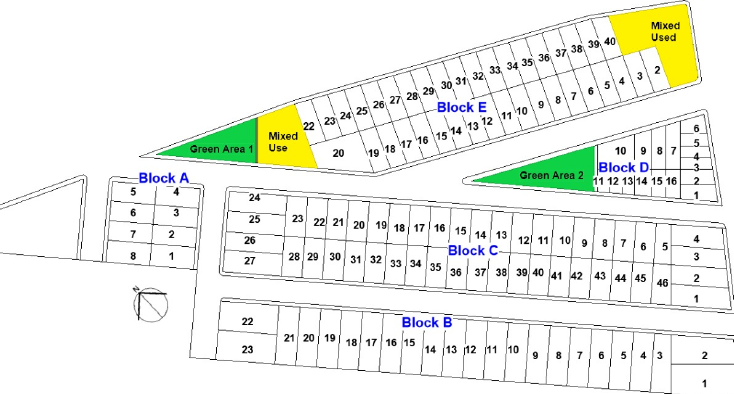
Figure 3. Site plan of the Residential housing project.